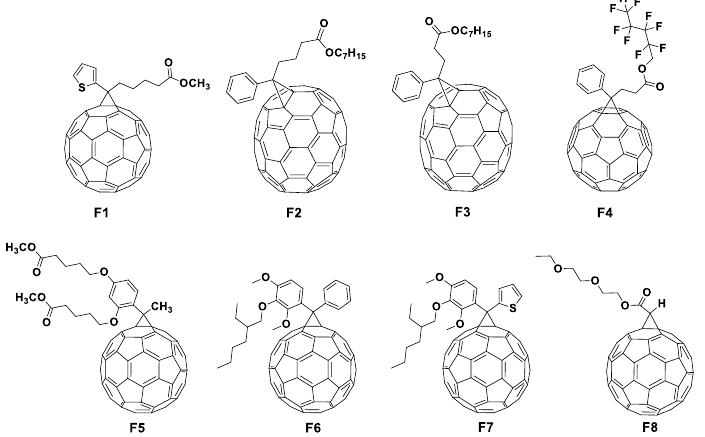
Figure 1. Molecular structures of the studied fullerene derivatives. Note: only the structure of the major isomer is shown in the case of [70]fullerene derivatives F2 and F3 .